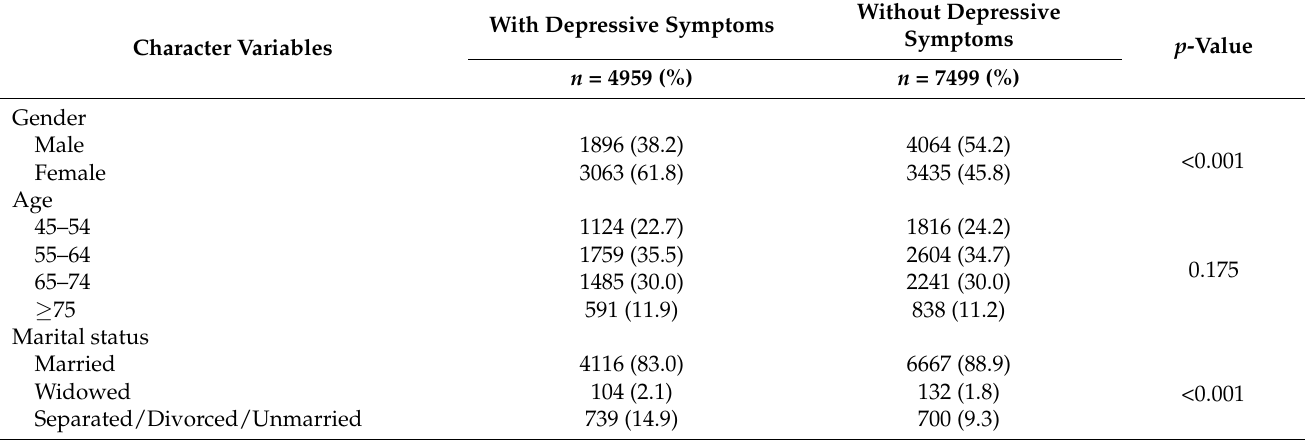
Table 1. Demographic characteristics of those with depressive symptoms and without depressive symptoms among chronic